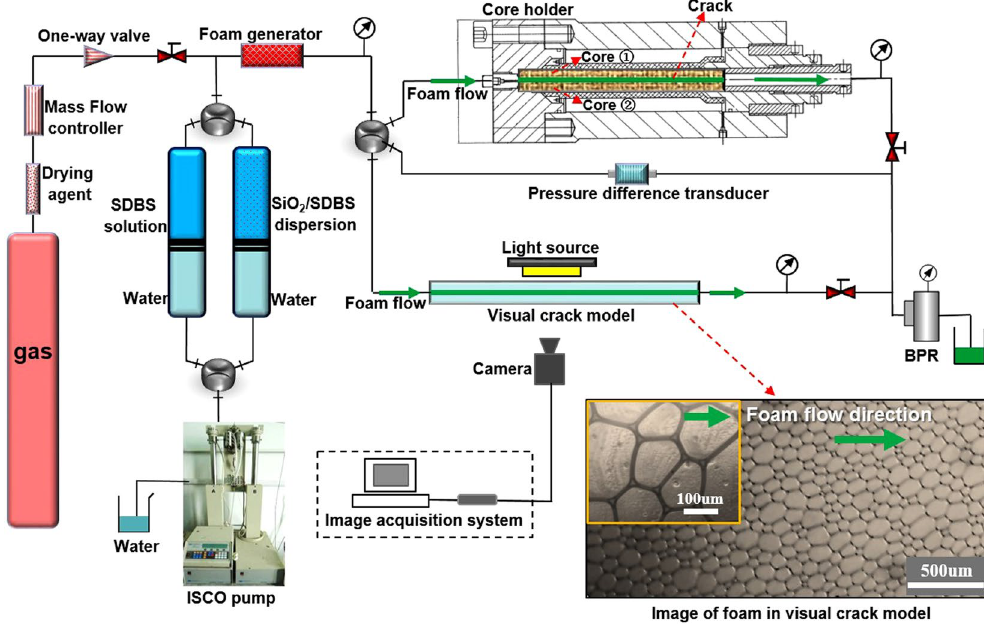
Figure 2. Schematic of foam slipping in core crack and visual crack experimental apparatus.